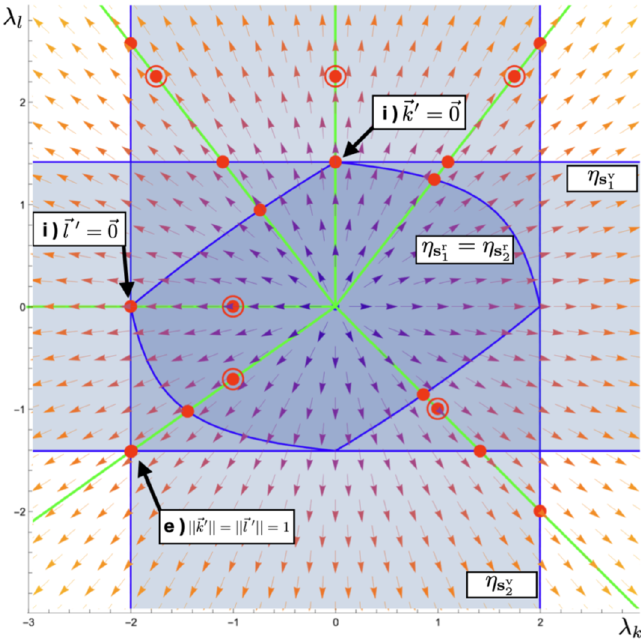
Figure 9. Causal flow of the DT supergraph with Q µ = (2 , 0 , 0 , 0) in the phase-space plane ( ~k 0 ,~l 0 ) = ((0 , 0 , λ ) , (0 , λ )) . Drawing 1 k l , λ l 2 conventions follow those of figure 8 and the points labeled “i)” are inte- grable singularities while the ones analoguous to “e)” correspond to the intersection of the two non- pinched E-surfaces of the double- triangle